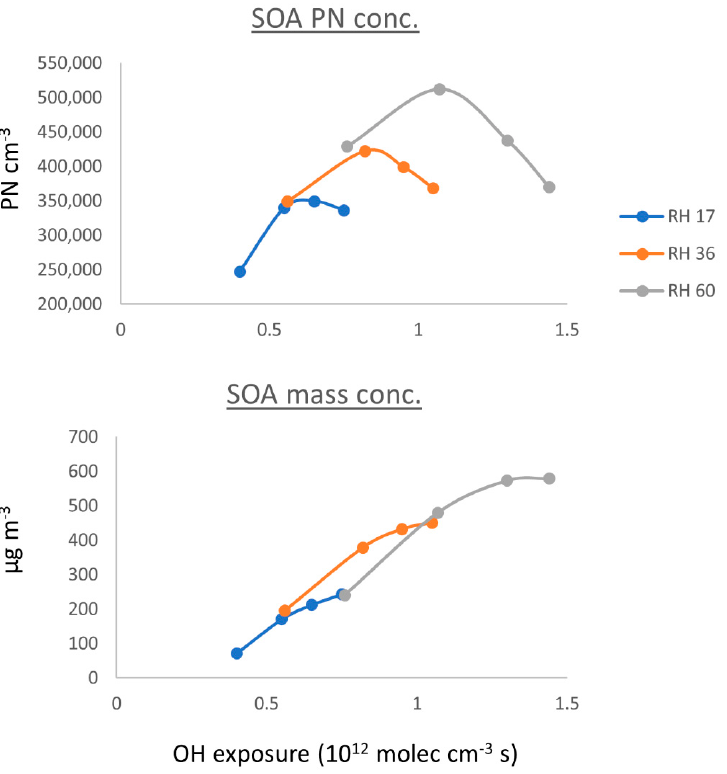
Figure 7. Changes of SOA particle number (PN) concentration and mass concentration under different RH and OH exposure.